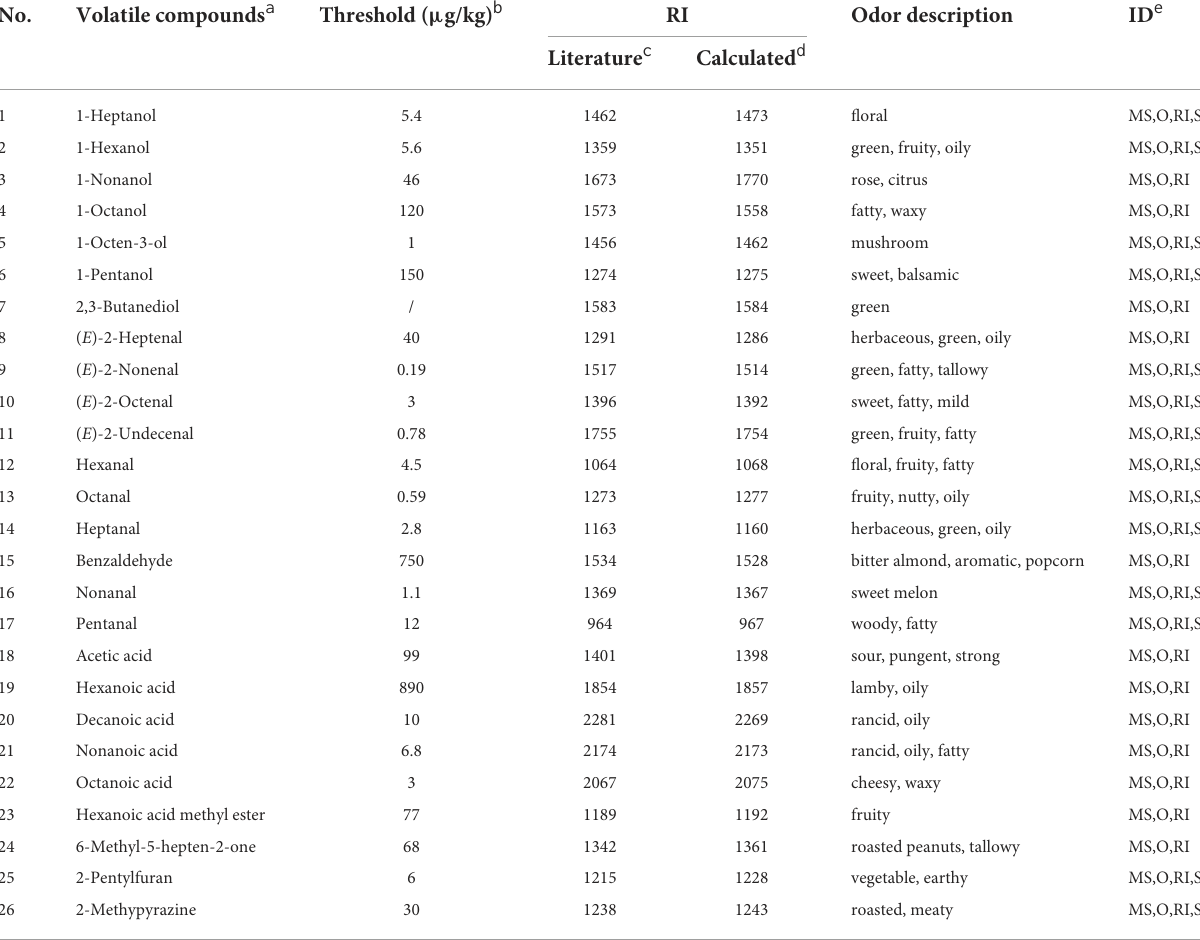
TABLE 1 Identification of aroma compounds in roasted Tan mutton for 0–14min.